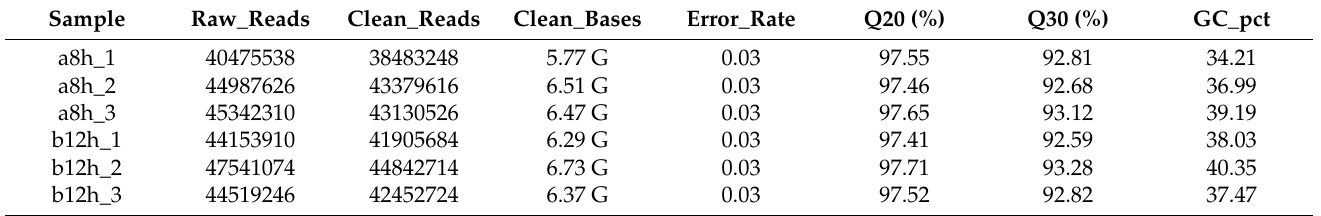
Figure 1. The numbers progeny per female per day ( a – c ) and total progenies per female ( d – f ) of first, third, and fifth generation cotton aphids under 8 L:16 D, 10 L:14 D, 12 L:12 D, and 14 L:10 D light–dark cycles. The results were represented as mean ± SE. Various letters above the bars indicate statistically significant differences between photoperiods (Tukey’s post hoc test; p < 0.05). Table 1. Quality control result of sequencing data of Aphis gossypii under 8:16 and 12:12 light–dark